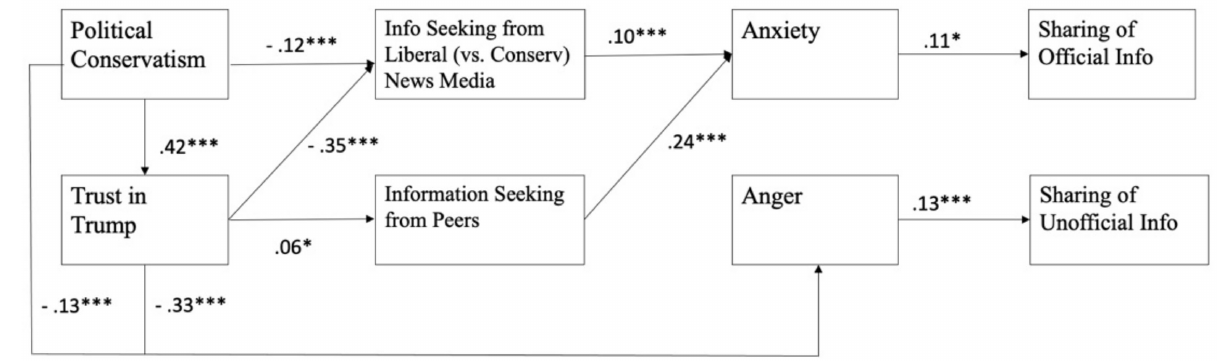
Figure 2. Estimated parameters from the path model. Note. *** p < 0.001 and * p < 0.05. Standardized coefficients are shown in the